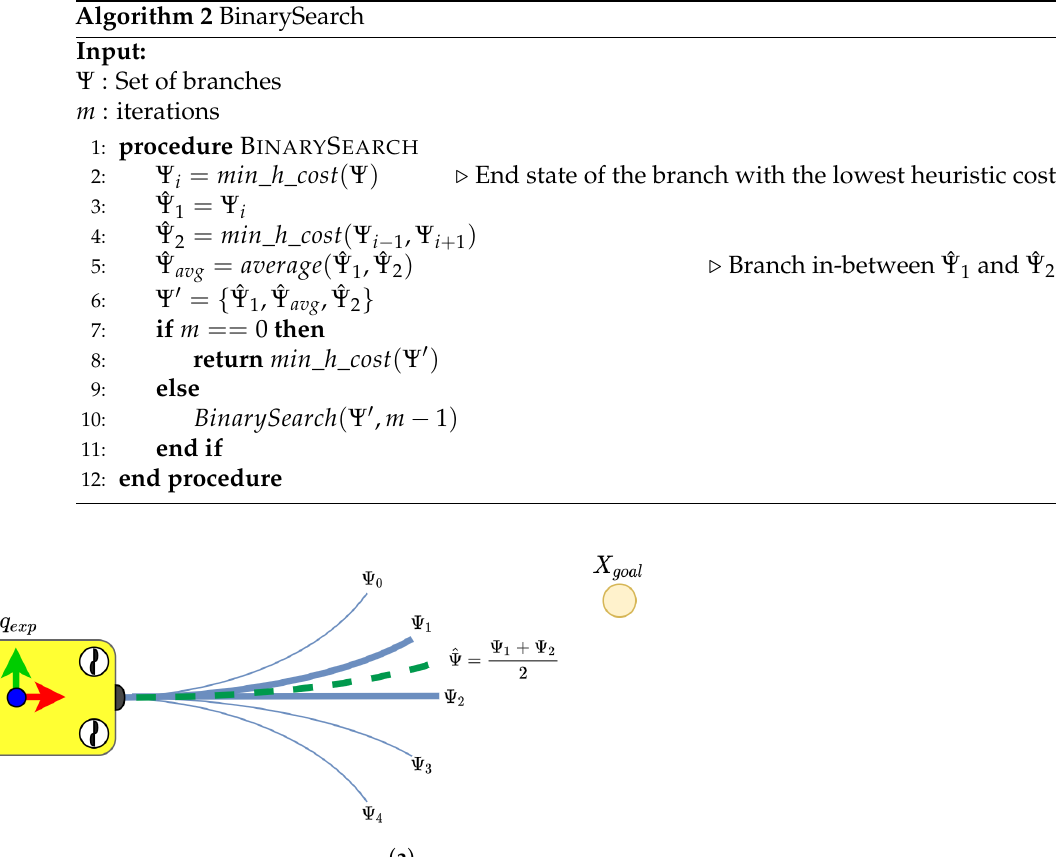
Algorithm 2 BinarySearch